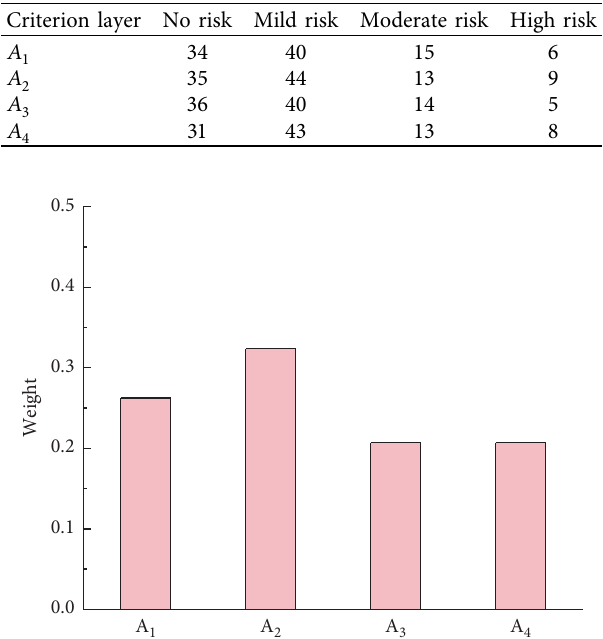
Figure 5: Schematic diagram of attribute weight of criterion layer.